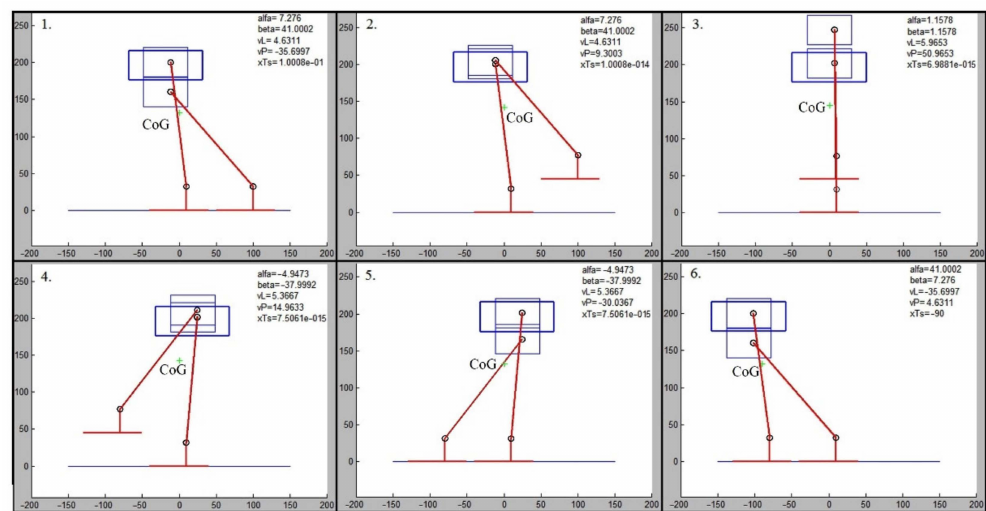
Figure 7. Plotted configurations of the robot when walking on a flat surface. Legends: 1—the center of gravity of the robot is above the right foot; 2—the left linear actuator performs the upward stroke of the left foot; 3—the left ankle joint rotates to move the left foot forward and at the same time the right ankle joint balances the robot’s pose to the vertical position of the legs; the right linear actuator also works to keep the base at a constant height; 4—the left ankle joint transmits the left foot forward and at the same time the left linear actuator lowers the foot; the right linear actuator also lifts the base to keep it at a constant height. 5—the left foot is lowered to the ground; 6—both ankle joints rotate so that the center of gravity is transferred above the left foot and at the same time the height position of the base is compensated by the movement of both linear actuators.